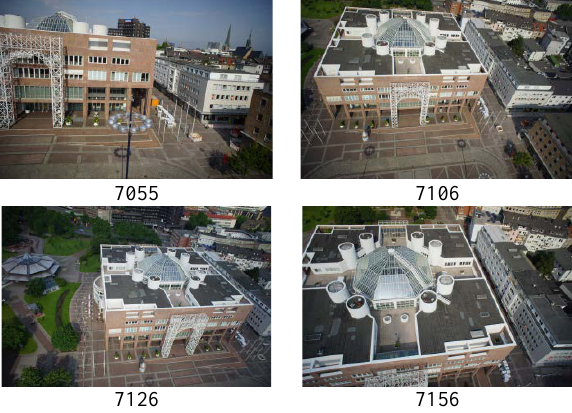
Figure 3: UAV images used for the tests Pair 1 – within terr-1: 2315- 2342 (standard) In Fig 4., the upper part the matches of SURF are displayed while in the lower part for each approach the number of inlier 2 OpenCV 3.0, including the API MEXOpenCV to use OpcnCV